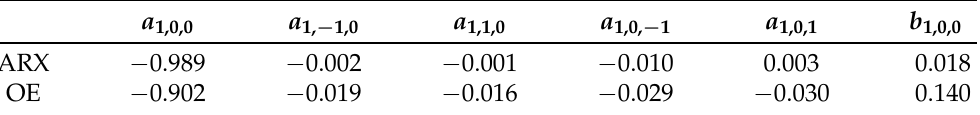
Table 5. Estimated model coefficients. Note, for brevity the same denotation of the parameters corresponding to shifted output values is used for both, ARX and OE